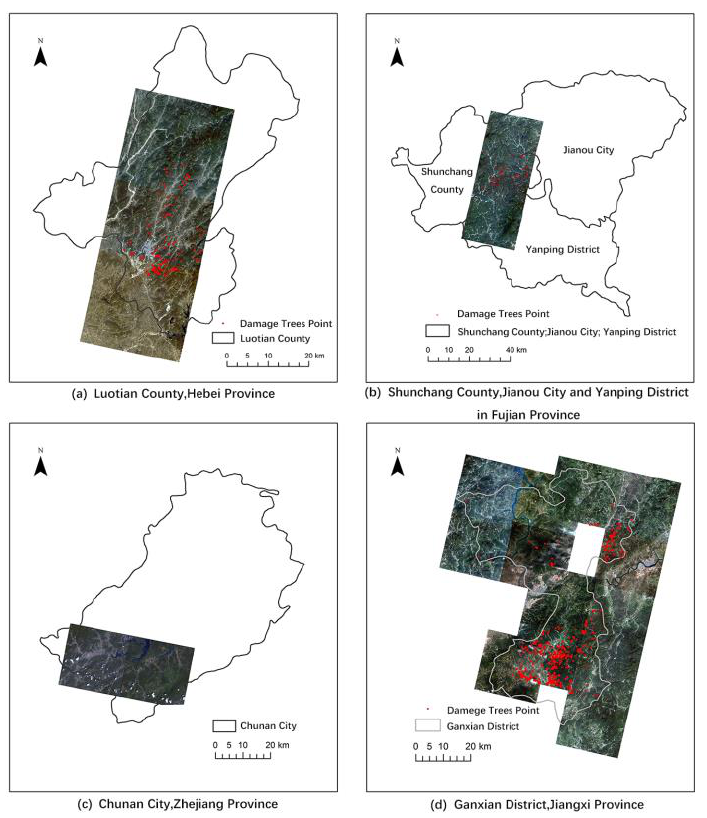
Figure 1. Study area (red dots indicate PWD infestation sites).